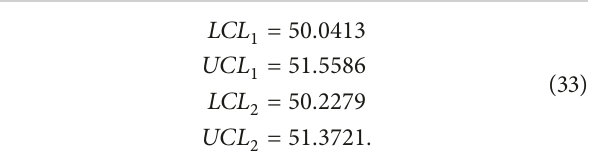
average value 𝜇 = 50. Data set of size 25 for both variables is as